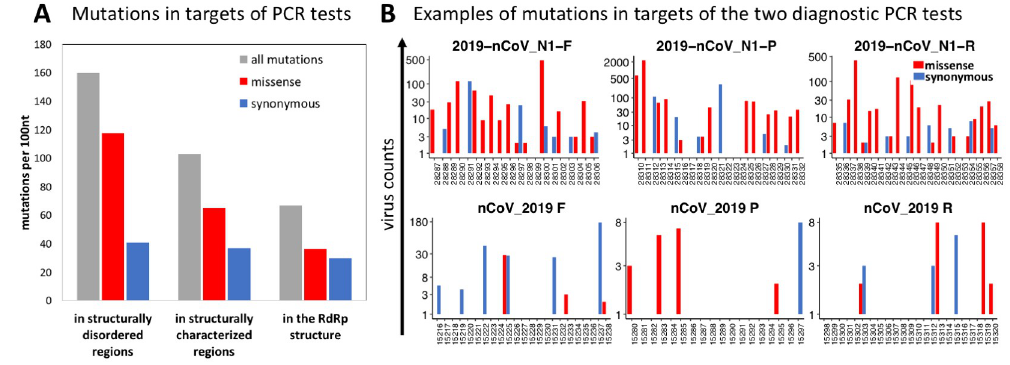
Fig 7. The frequencies of SARS-CoV-2 mutations in genomic regions targeted by the primers and probes of the diagnostic PCR tests A) The regions targeted by popular PCR tests have lower missense mutation rates when those regions are structurally characterized or map to the RdRP structure, and higher missense mutation rates when the regions are structurally disordered. On the other hand, the rate of synonymous mutations remains roughly the same. B) Examples of the effects of constraints imposed by encoded proteins on rates of mutations in regions targeted by the PCR tests. The region targeted by the 2019-nCoV_N1 PCR test (top) encodes the structurally disordered linker region of the Nucleocapsid protein. The region targeted by the nCoV_2019 PCR test (bottom) encodes the RNA-dependent RNA polymerase (RdRP). All reported counts are based on 192,030 high-coverage genomes obtained as of Dec 3 rd , 2020 from the GISAID website.